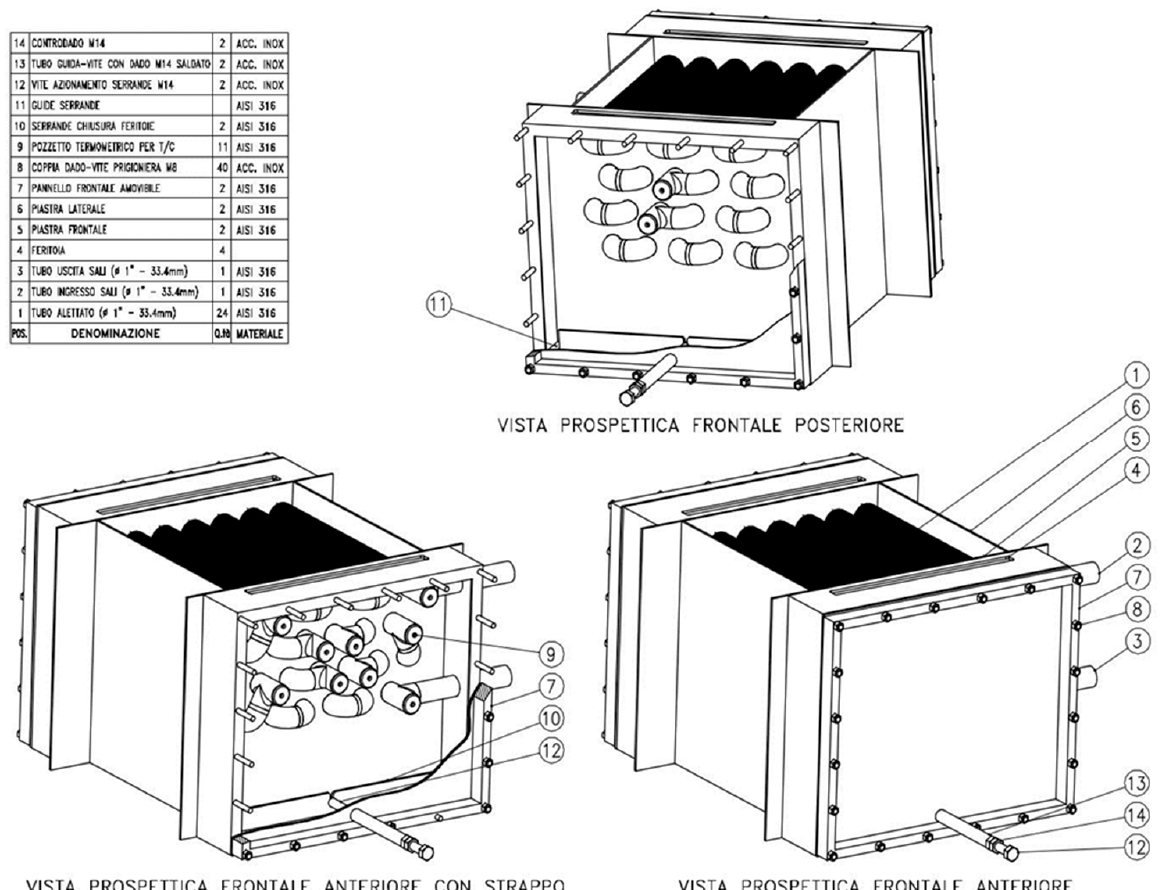
Figure 6. 3D drawings of the designed MSH mock up.